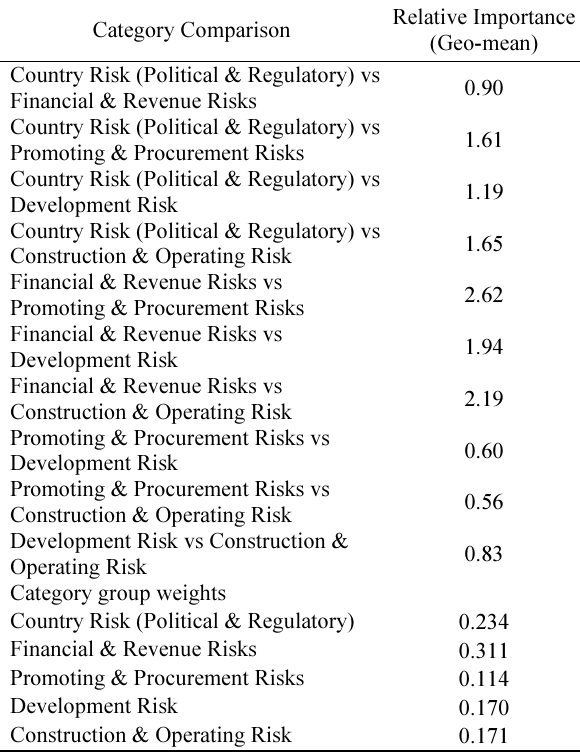
Table 2. Category group pairwise comparison and group rela-